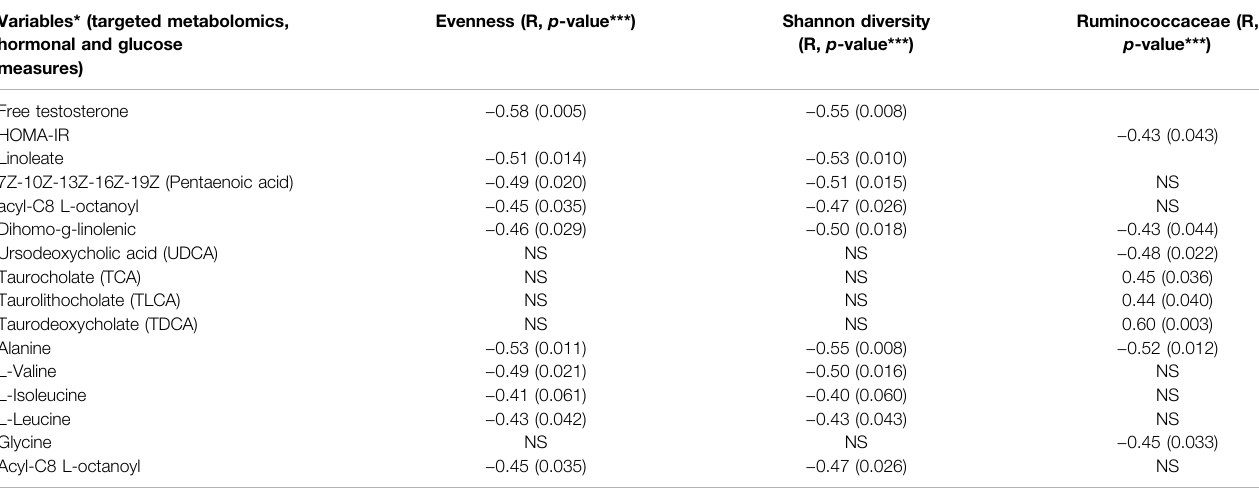
*Variables from Table 1 were run for correlation with α -diversity indices and phyla and family bacterial taxa (N = 22). When signi fi cant, results are shown with R value, ( p -value); NS, not signi fi cant, p -values > 0.06.; *** p -values are unadjusted for multiple comparison.